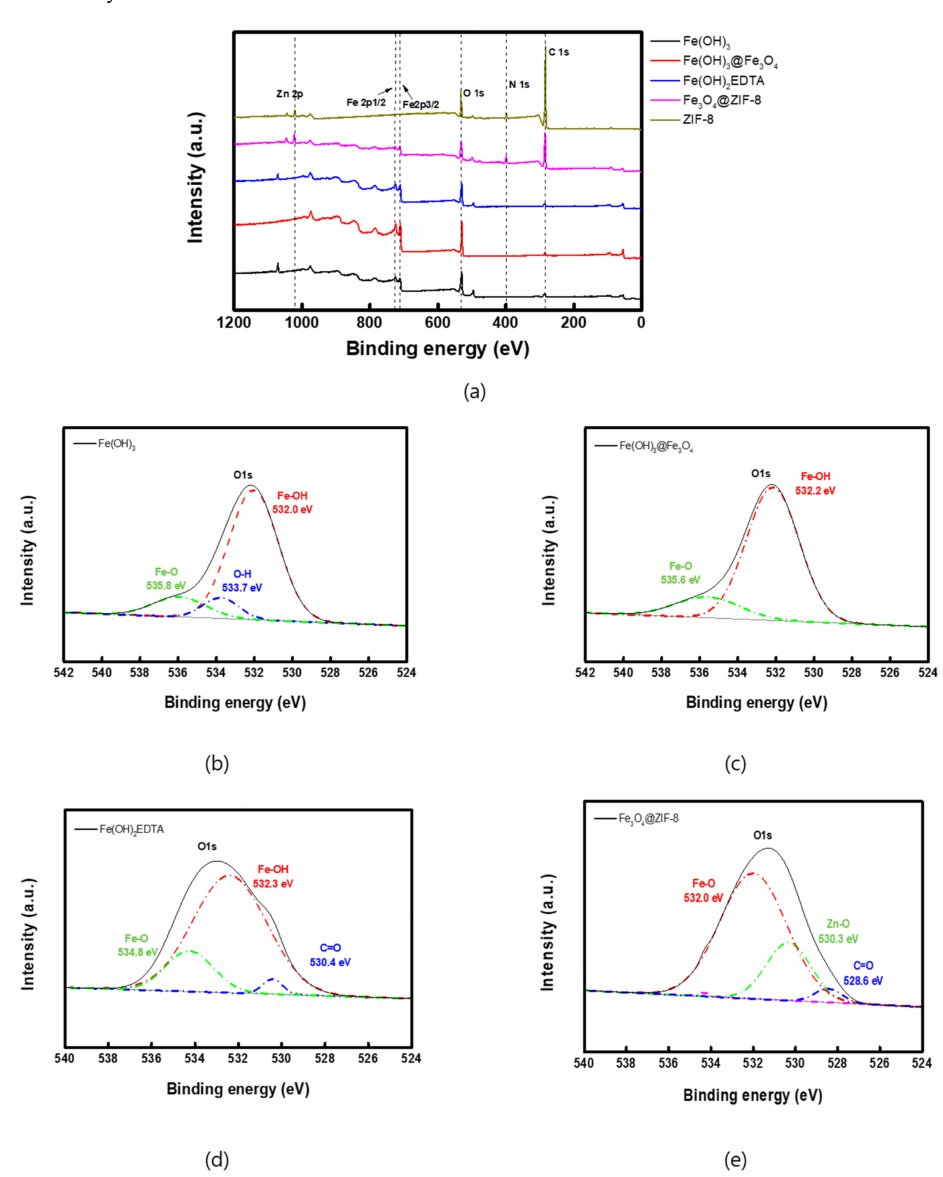
Figure 6. XPS spectra of ( a ) all catalysts, ( b ) Fe(OH) 3 -(O1s), ( c ) Fe(OH) 3 @Fe 3 O 4 -(O1s), ( d ) Fe(OH) 2 EDTA- (O1s), ( e ) Fe 3 O 4